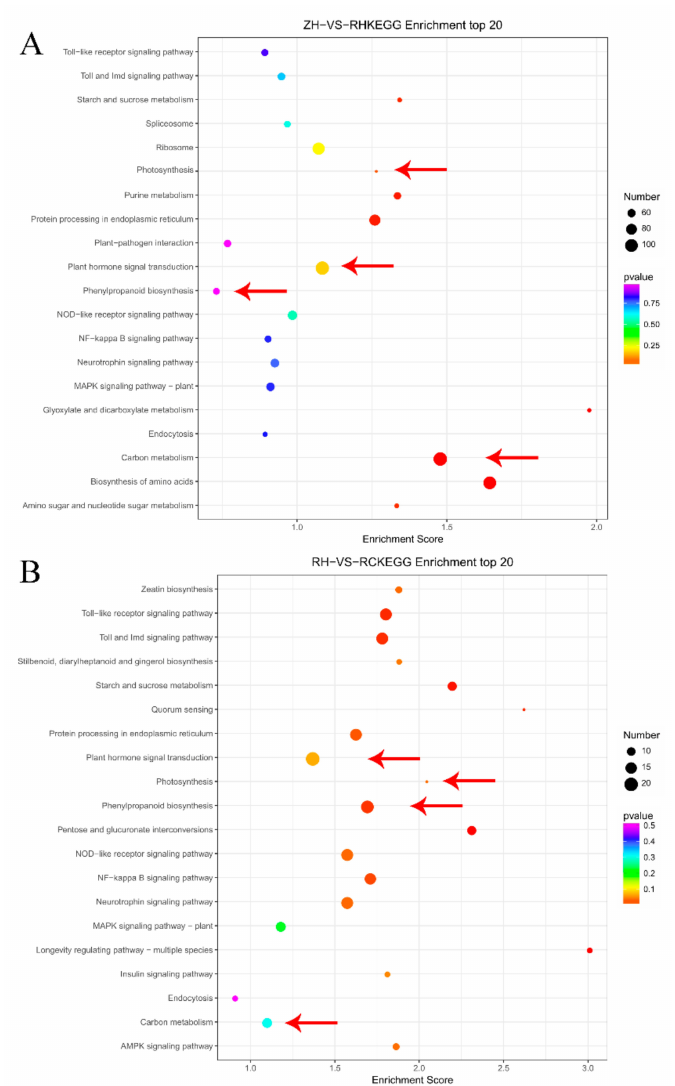
Figure 6. The top 20 enriched KEGG pathways were analyzed for the DEGs. ‘Enrichment factor’ is the ratio of the DEGs to the background number in the given pathway. The dot size represents the number of genes, and the color represents the q-value range. ( A ) The top 20 KEGG pathways were analyzed in ZH vs. RH. ( B ) The top 20 KEGG pathways were analyzed in RH vs.